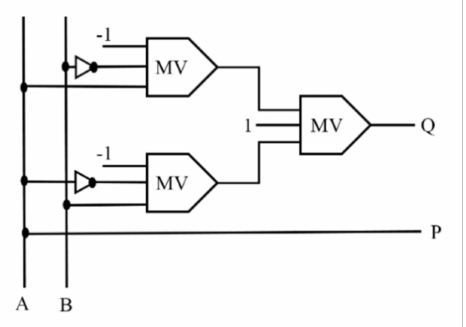
Figure 2. The diagram of the Feynman gate in the QCA [26].